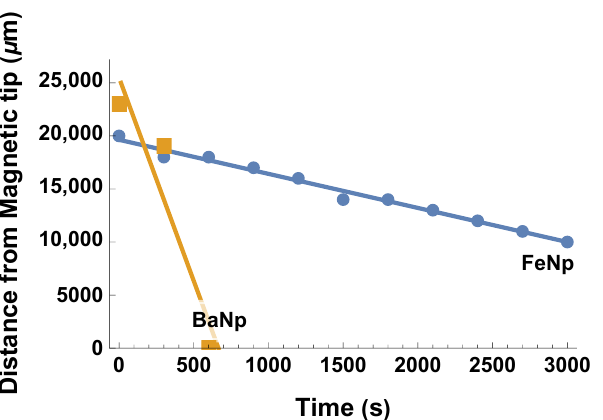
Figure 2. Magnetic nanoparticle position as a function of time, a graphical approach to v ter in the presence of gravity only. Data points from experiments were plotted with a linear curve fit. The slope of this curve is then taken as the v ter under gravity.